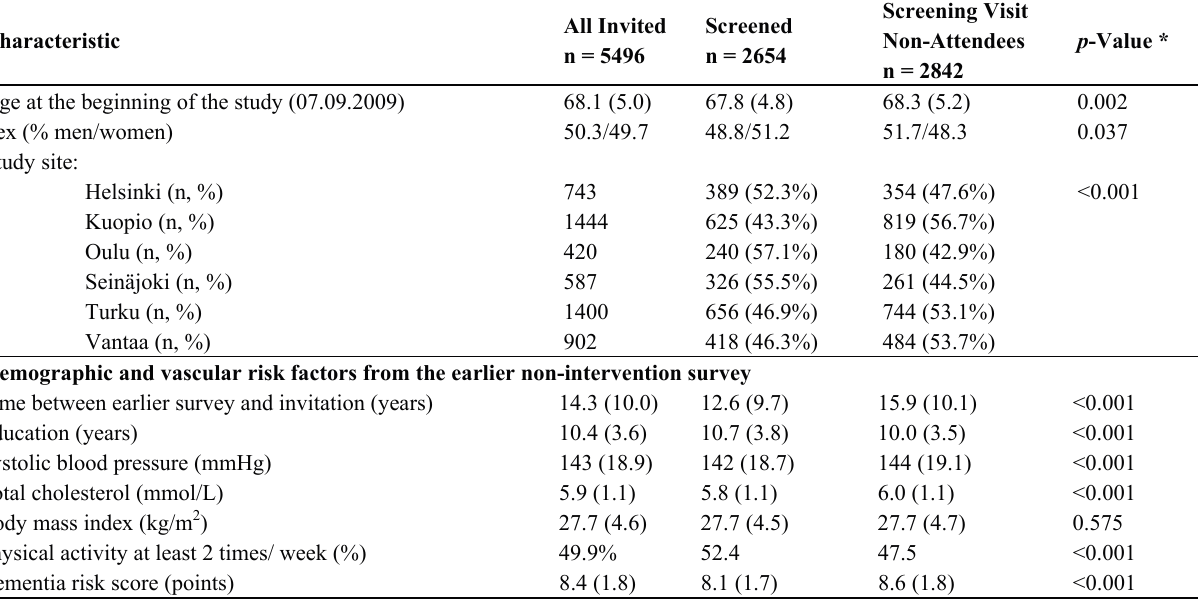
Table 1. Background characteristics from earlier surveys and health registries of the persons who were invited to attend the FINGER study screening visit (mean (SD) or